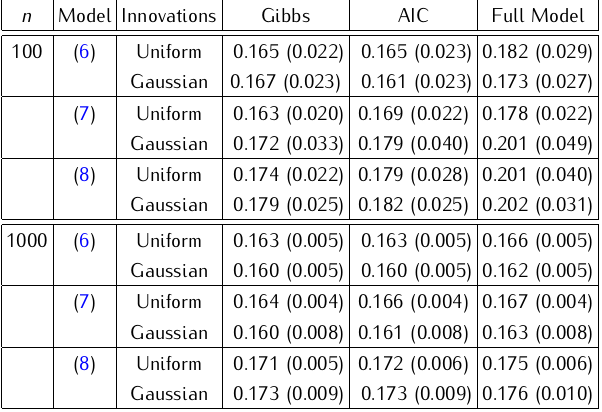
Table 4. Performances of the Gibbs, AIC and “full model” predictors on